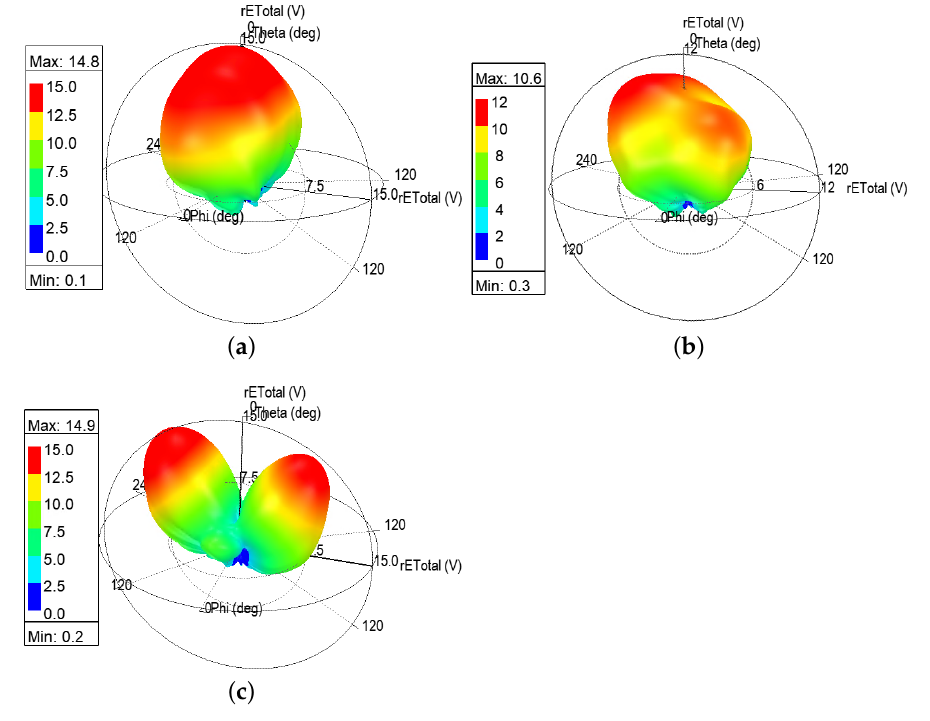
Figure 21. E-field 3D plot for d ant = 0 mm. ( a ) E-field 3D plot at 5.8 GHz; ( b ) E-field 3D plot at 6.2 GHz; and ( c ) E-field 3D plot at 8.4 GHz.